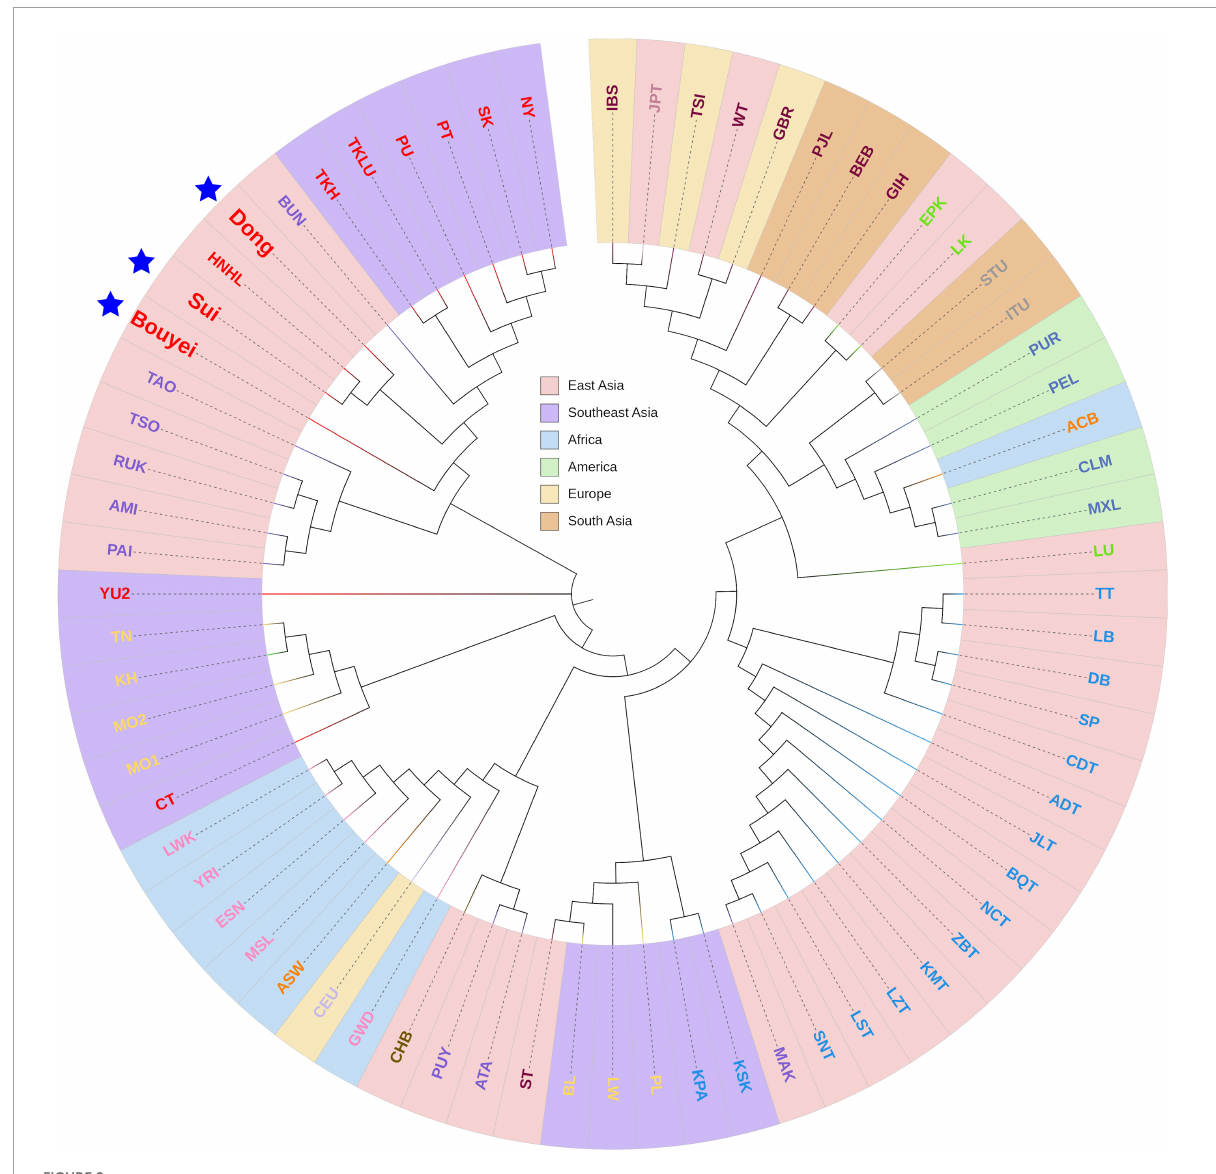
FIGURE8 The phylogenetic NJ tree of three Guizhou Tai-Kadai-speaking populations and 68 reference populations. The tree colored according to its geographical origin. Highlight Bouyei, Sui, and Dong with blue